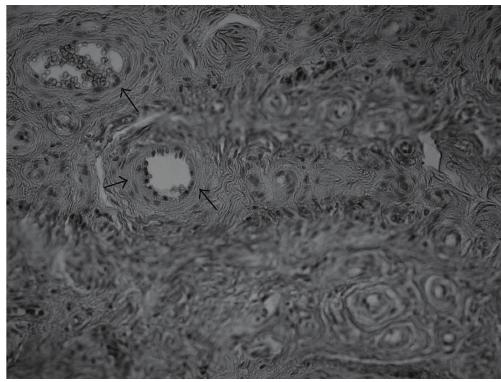
Figure 5: Proliferation of capillaries with hyaline perivascular material (arrows; 400x,